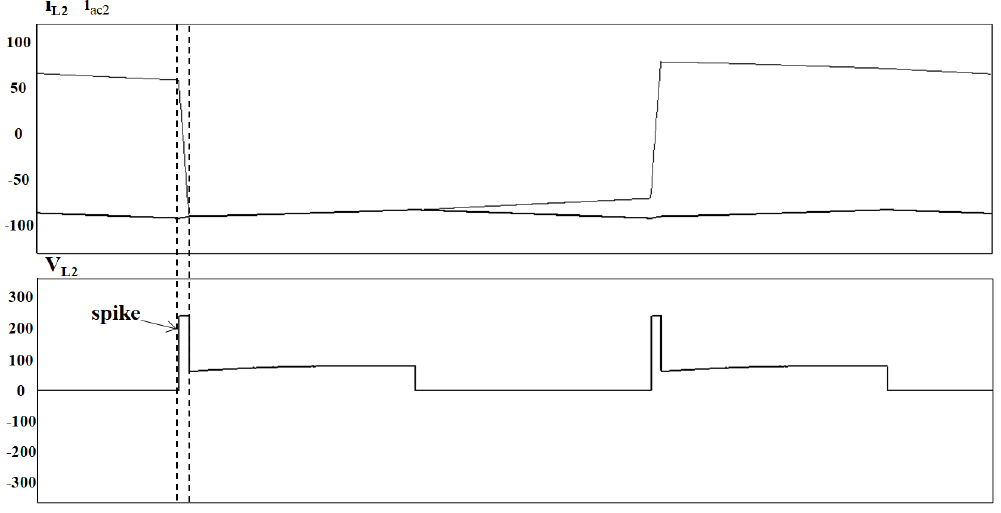
Figure 7. Zoom on the secondary-side waveforms for the conventional PSM.